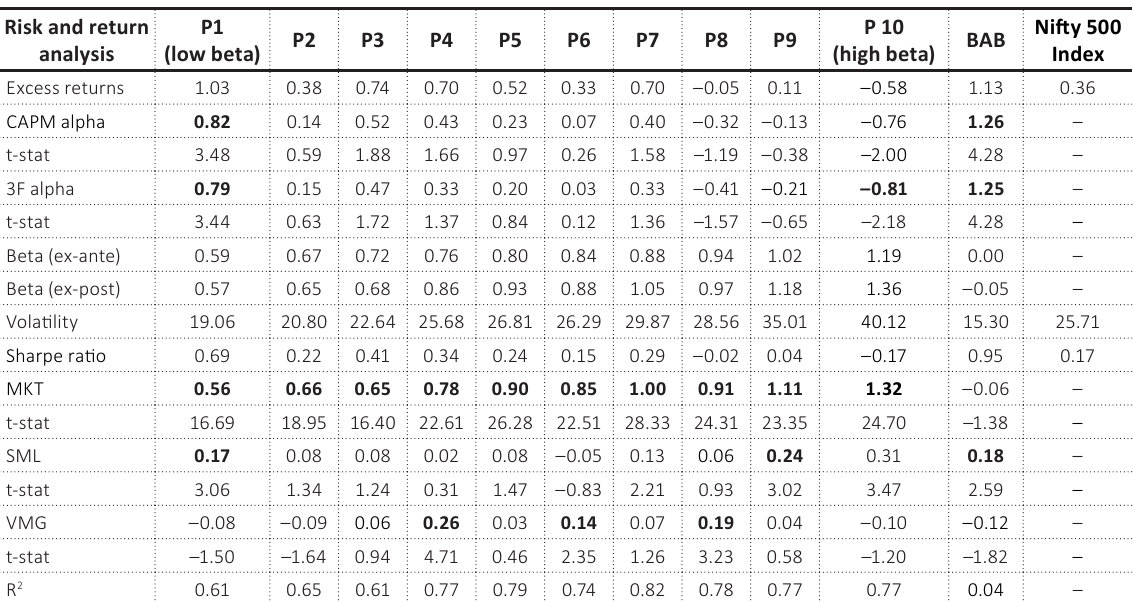
Table 1. Performance of beta-sorted portfolios and BAB